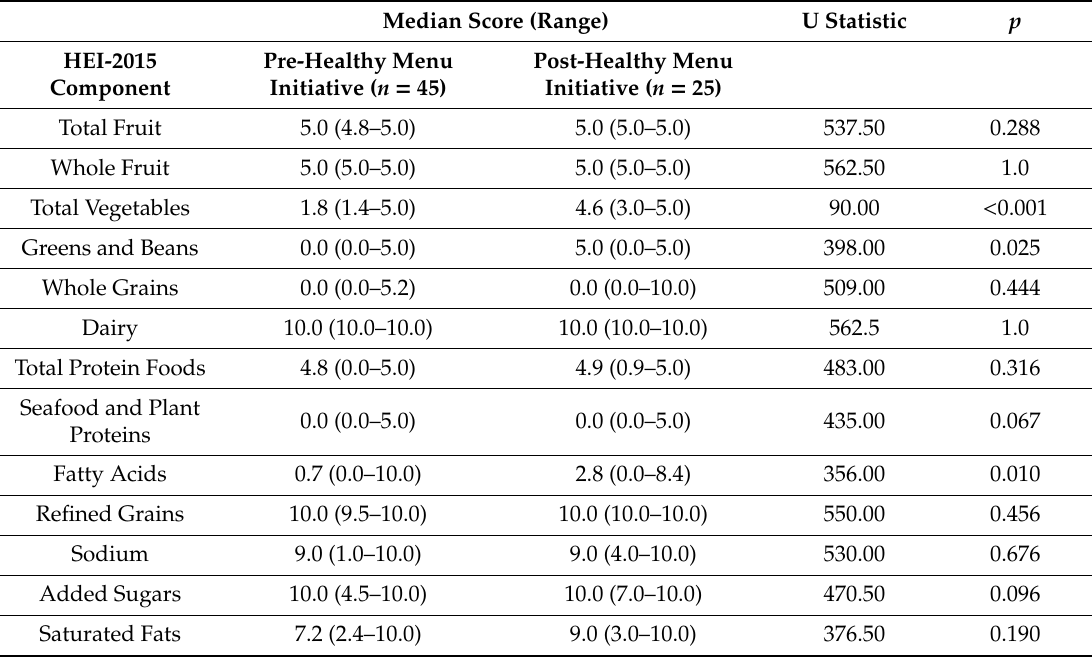
Table 3. Comparison of pre-initiative and post initiative HEI-2015 component